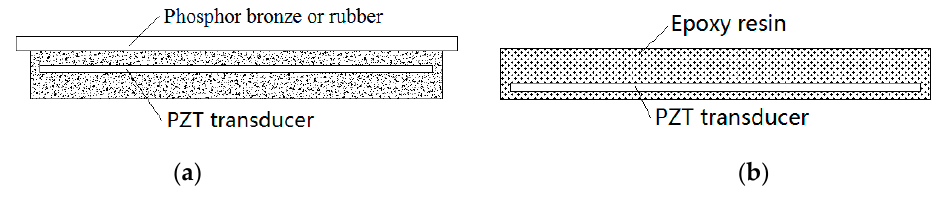
Figure 10. Packaging structure with different materials. ( a ) rubber and phosphor bronze; and ( b ) epoxy resin.